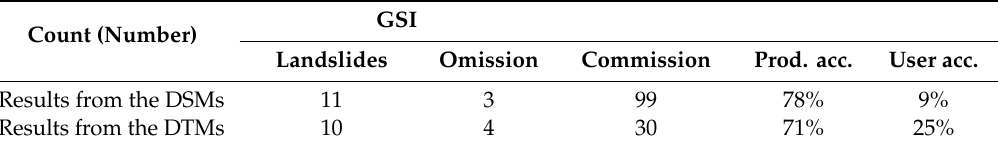
Table 4. Comparison of the detected results with the landslides identified by NIED (m 2 ).